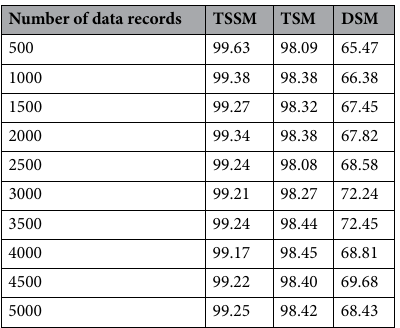
Table 6. Detailed information of reduction rates of data retrieval time to TSSM, TSM,